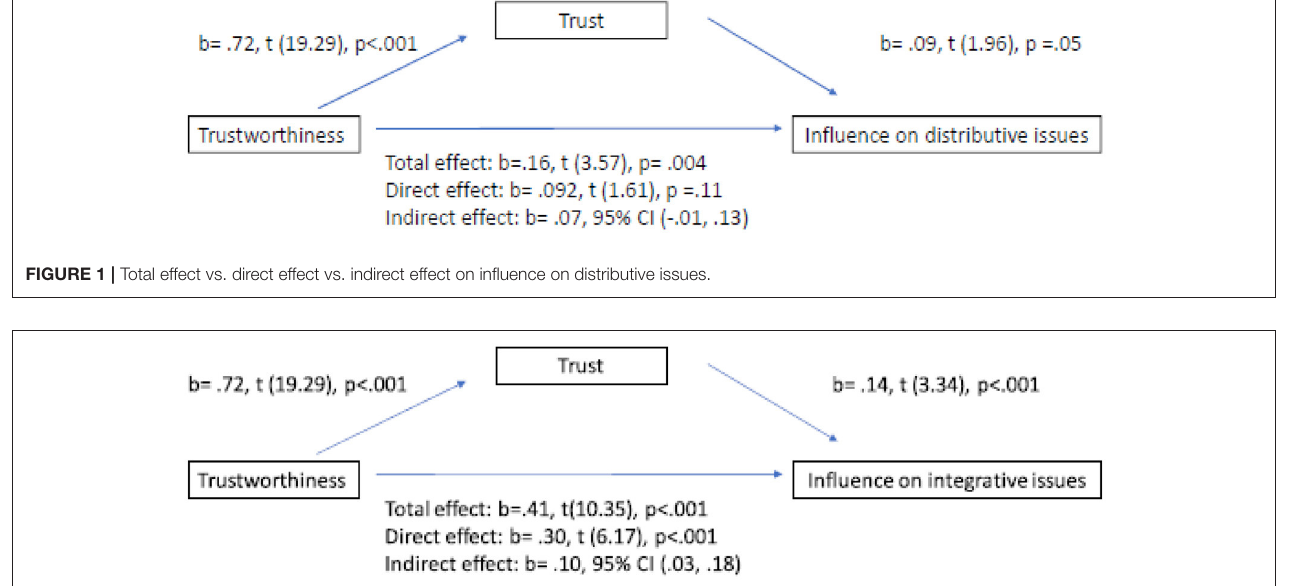
FIGURE 2 | Total effect vs. direct effect vs. indirect effect on influence on integrative